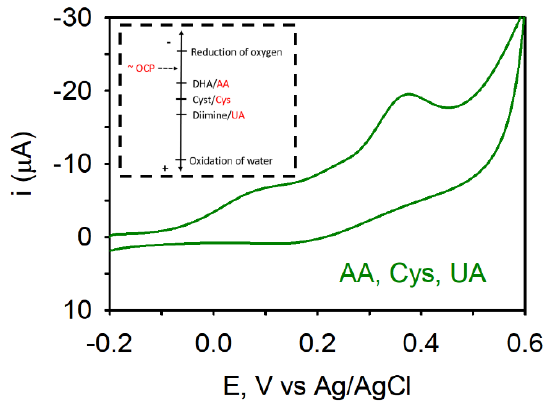
Figure 5. CVs acquired at an NPG electrode in a solution containing 0.5 mM ascorbic acid (AA), cysteine, and uric acid (UA) in pH 7.4 0.1 M PB at a scan rate of 50 mV/s. Inset: Thermodynamic prediction of the approximate location of the OCP (rest) potential of NPG in an equimolar solution containing AA, CYS, and UA.